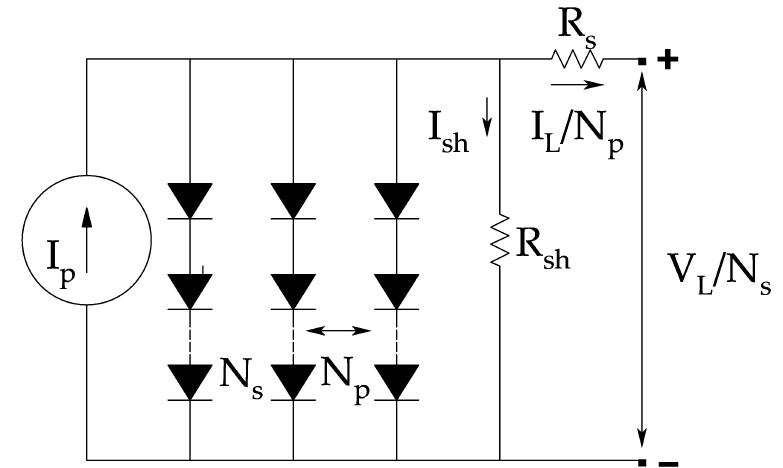
Figure 1. Equivalent circuit of PV panel module